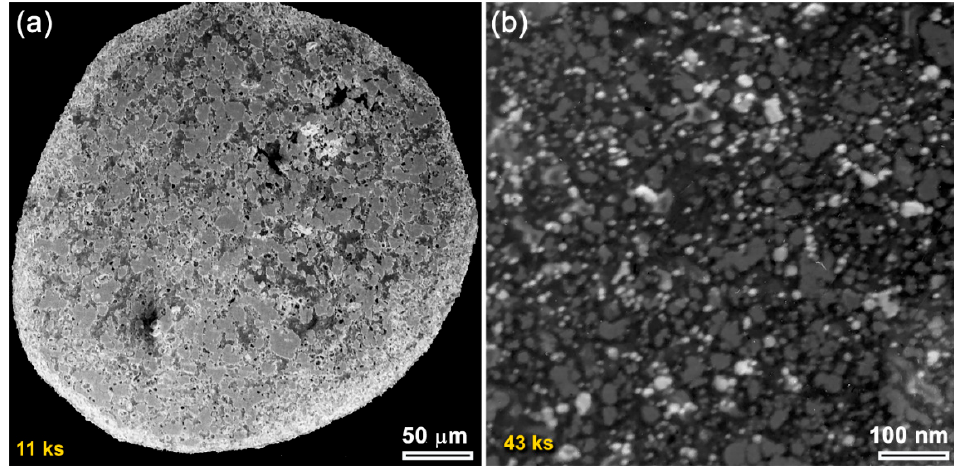
Figure 2. ( a ) Bright-field (BF) image; ( b ) the corresponding selected area diffraction pattern (SADP) of Zr powders obtained after 11 ks of RBM time; ( c ) field-emission scanning electron microscope (FE-HRTEM) image of the RBM powders for 22 ks.